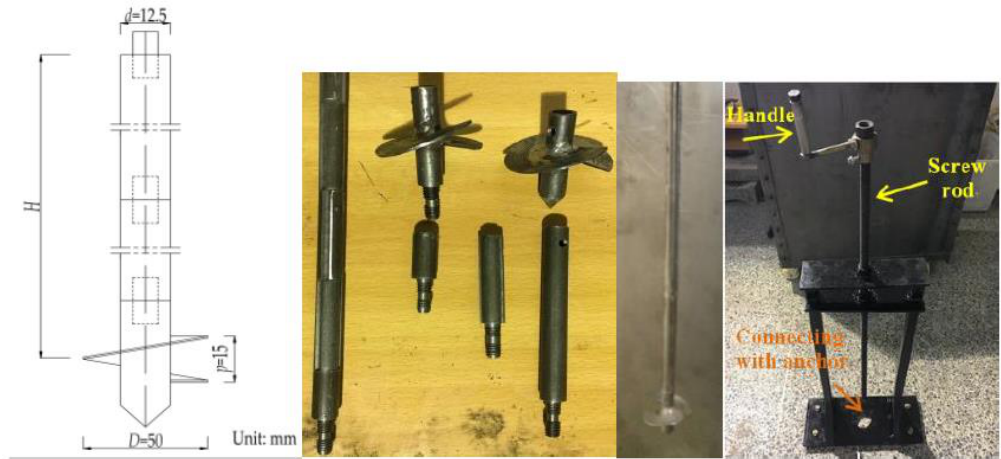
Figure 1. Model of helical anchor and torsion mounting frame.